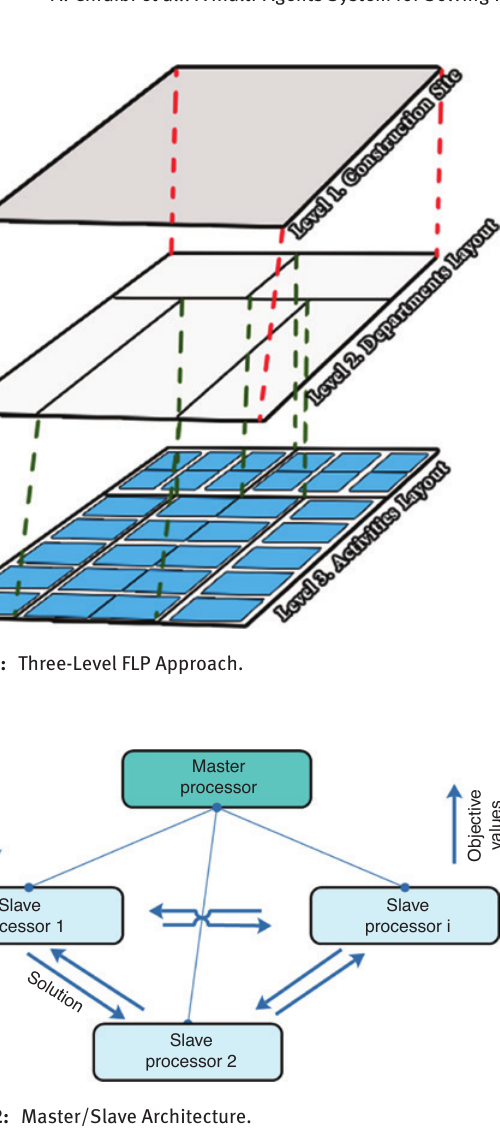
Figure 2: Master/Slave